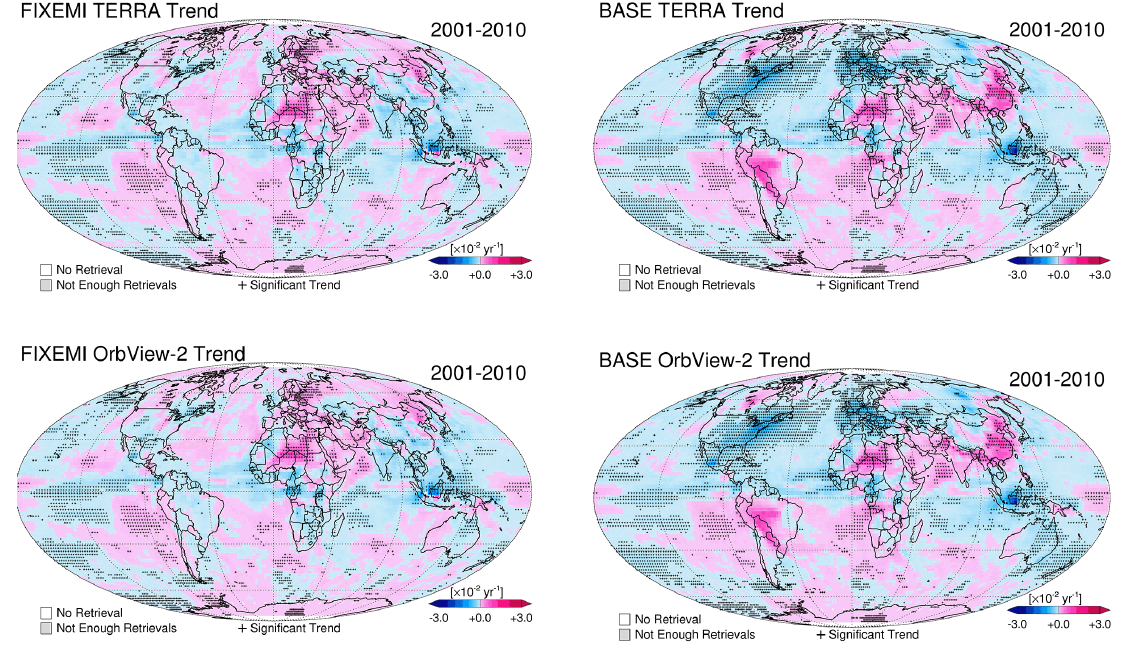
Figure 3. Linear trend between 2001 and 2010 in 10 − 2 year − 1 for simulations FIXEMI and BASE (left and right column respectively) estimated using the output of the submodel SORBIT, i.e., at the correct overpass time of the TERRA and OrbView-2 platform.